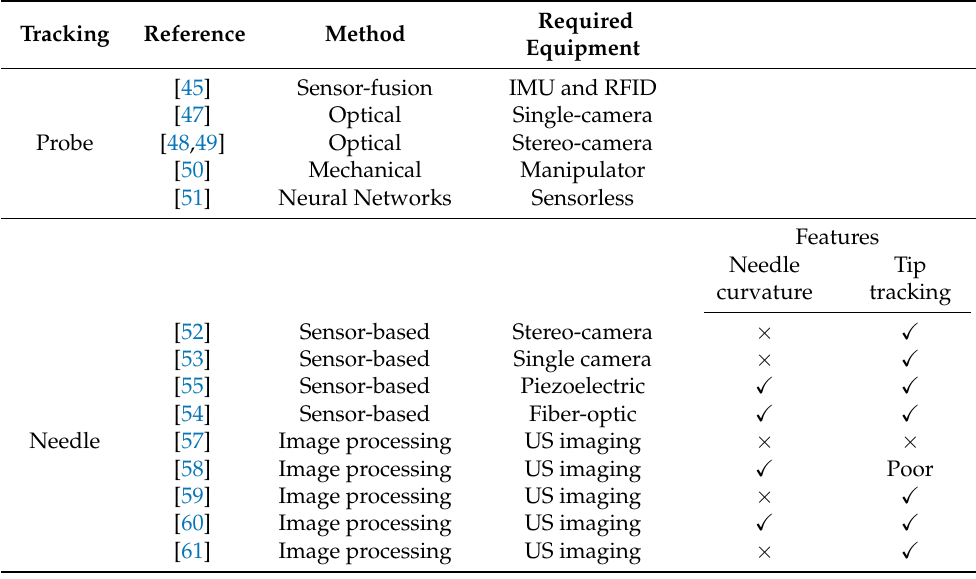
Table 2. Probe/needle tracking methods and